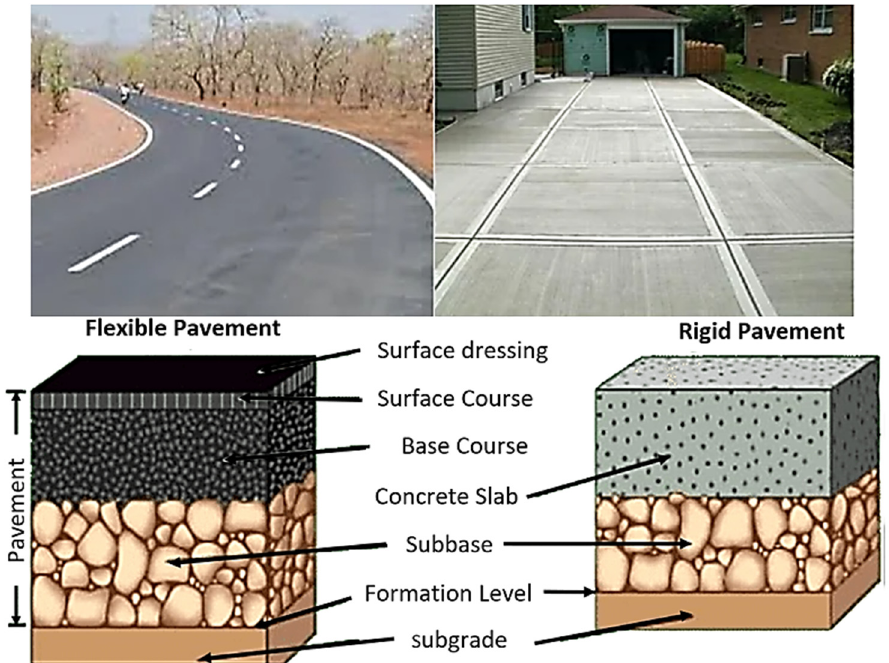
Figure 5. Difference between flexible and rigid pavement [33].